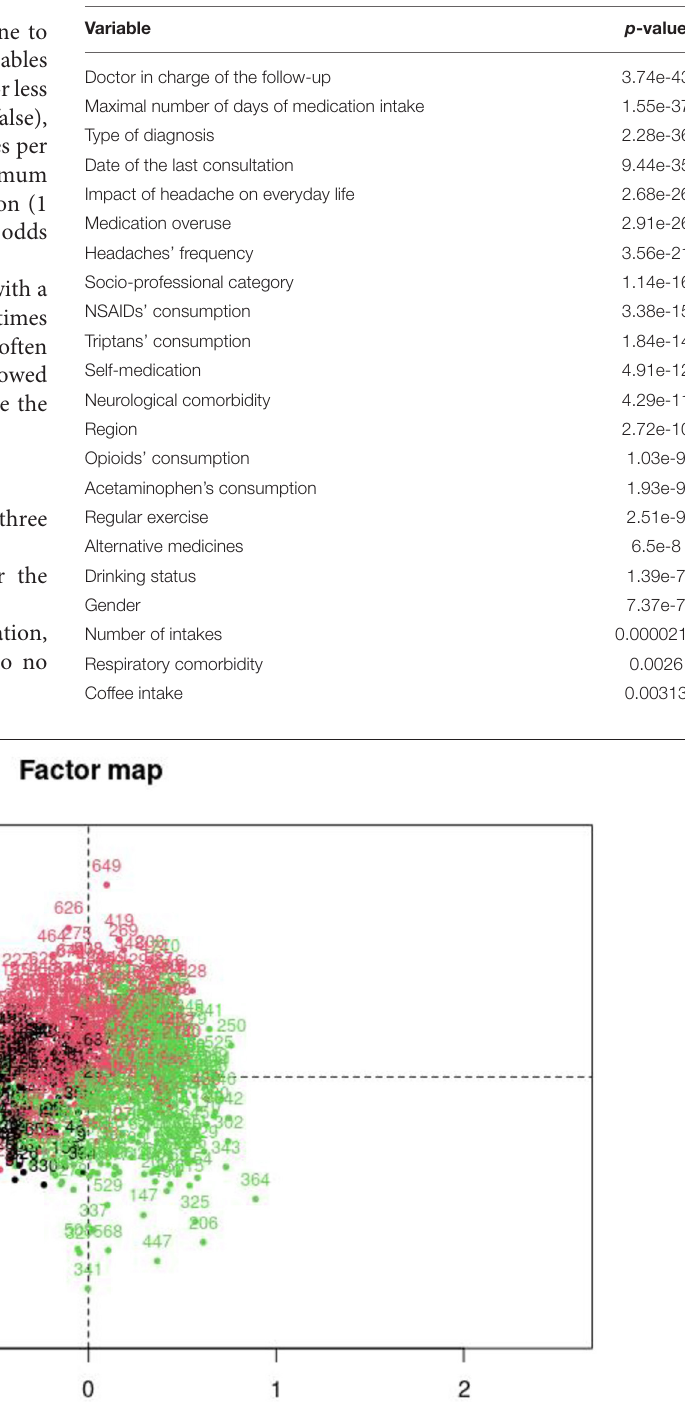
Frontiers in Digital Health |